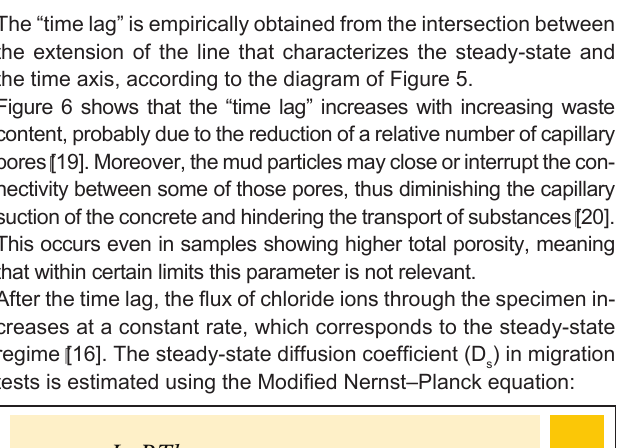
Figure 7 – Chloride ion flow (J ) as a function of red mud content in concrete cured for 28 days, estimated from migration